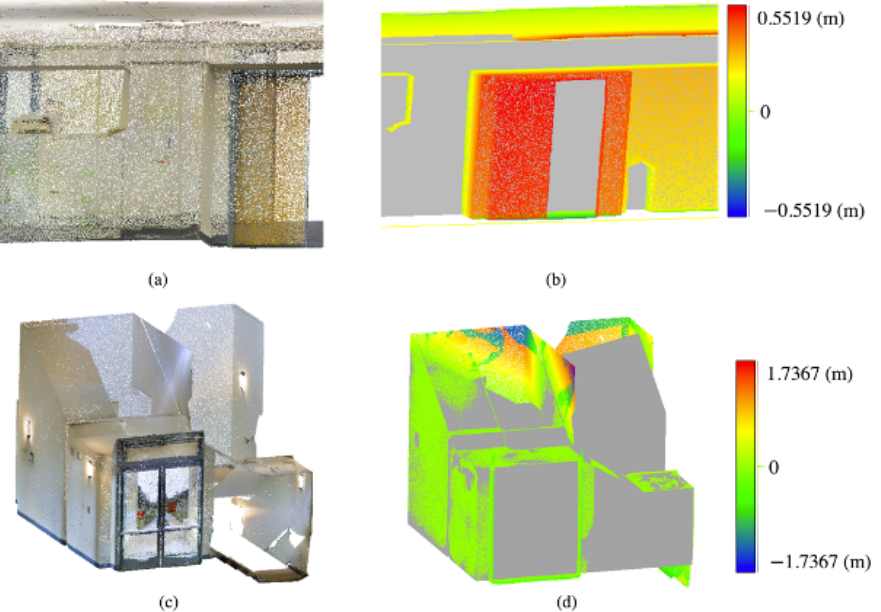
Figure 10. Large fitting errors (in meters) in hallways of Dataset 1: ( a ) raw data of Hallway 7; ( b ) color-coded maximum fitting error for the visible model; ( c ) raw data of Hallway 8; ( d ) color-coded maximum fitting error for the visible